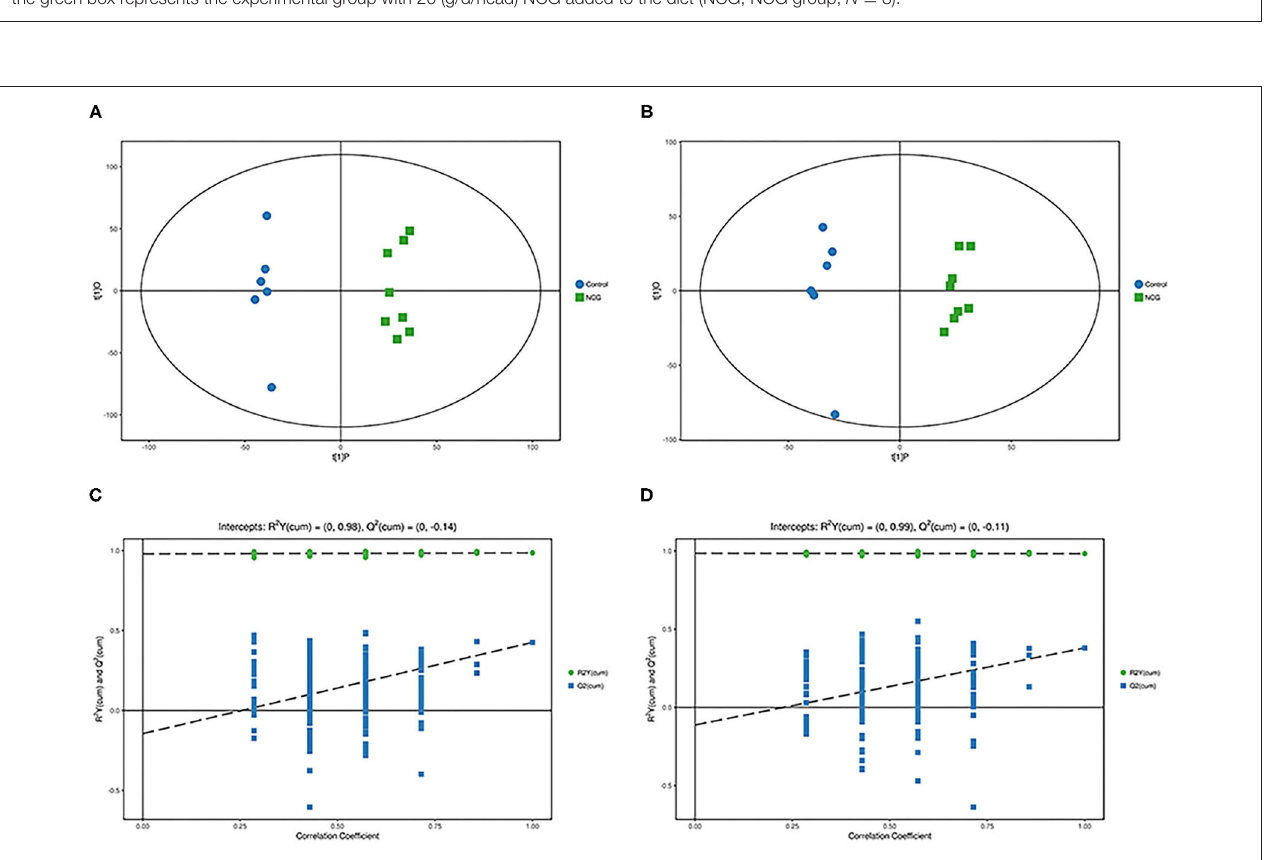
FIGURE 5 | (A,C) Orthogonal partial least square–discriminant analysis of scores and permutation test plots for the NCG group and CON group feces samples analyzed in the positive ion mode, respectively. (B,D) Orthogonal partial least square–discriminant analysis of scores and permutation test plots for the NCG and CON group feces samples analyzed in the negative ion mode, respectively. t[1]P = first principal component score. t[1]O = orthogonal principal component score. The intercept limit of Q 2 , calculated by regression line, is the plot of Q 2 from permutation test in the OPLS–DA model. The blue circle represents the diet without NCG supplementation (Control, CON group, N = 6), and the green box represents the experimental group with 20 (g/d/head) NCG added to the diet (NCG, NCG group, N = 8).